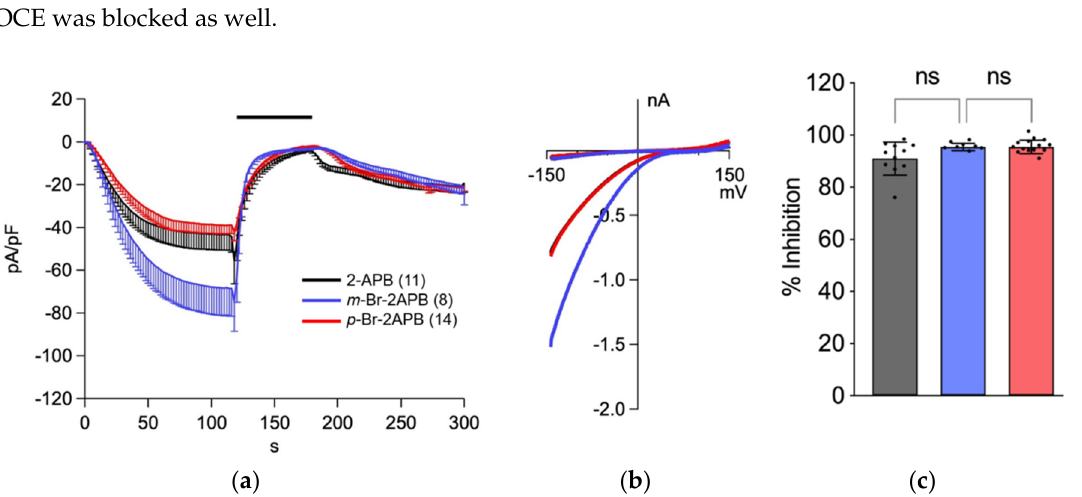
Figure 5. Inhibition of I CRAC in HEK293 cells overexpressing human STIM1/Orai1 by 2-APB (black traces) and analogues m -Br-2APB (blue) and p -Br-2APB (red). ( a ) I CRAC was evoked with 20 mM BAPTA and 50 µM IP 3 in the patch pipette, currents at − 130 mV were normalized to cell capacity and plotted as current density (CD) versus time. Upon I CRAC development, 2-APB (black), m -Br-2APB (blue) or p -Br-2APB (red) were applied from 120–180 s (black bar above traces). ( b ) I-V curves extracted from recordings in ( a ) when I CRAC had developed at t = 118 s. ( c ) Inhibition of I CRAC was calculated from CD at 180 s normalized to the point in time before compounds were applied ( t = 118 s) and plotted as inhibition in %. All compounds applied at 50 µM, number of experiments ( n ) in brackets in panel ( a ). Data shown are mean ± SD. Statistical significance is indicated as ns for not significant ( p > 0.05).